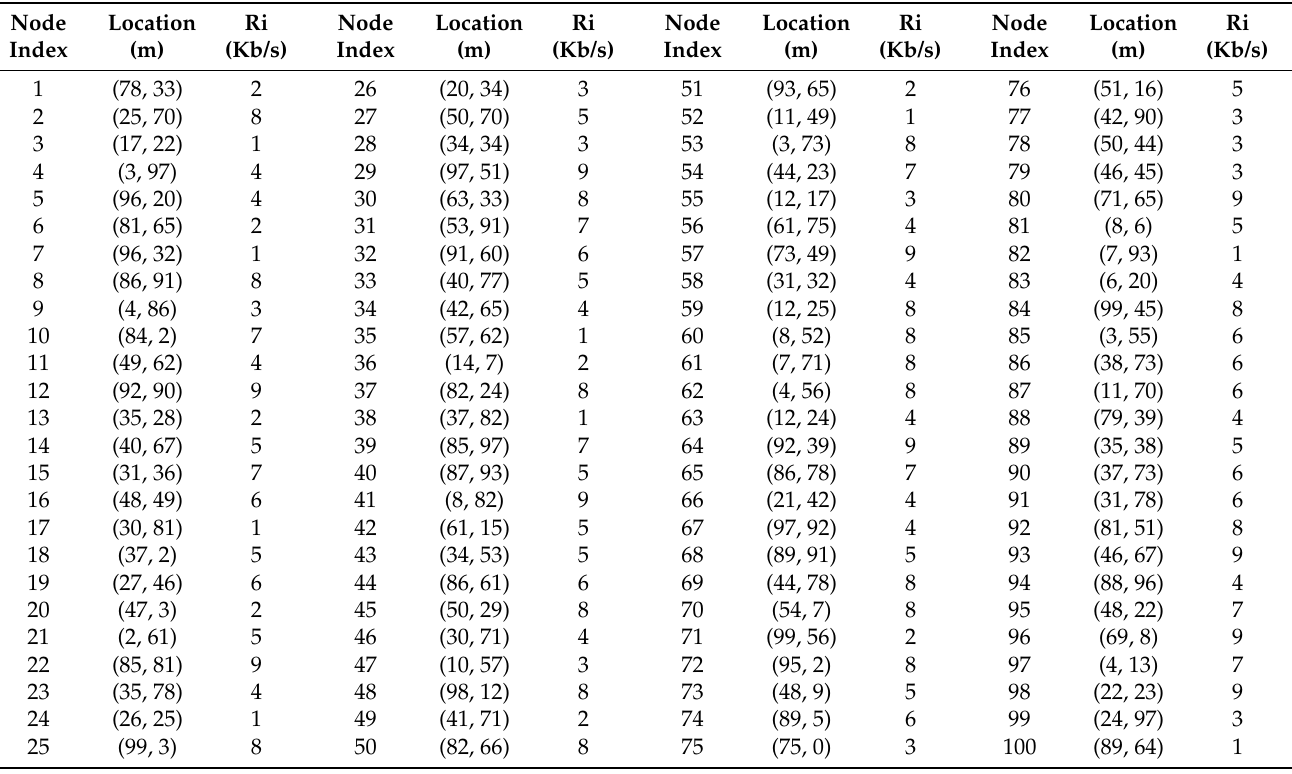
Table 1. Position and data rate of our 100-node network.